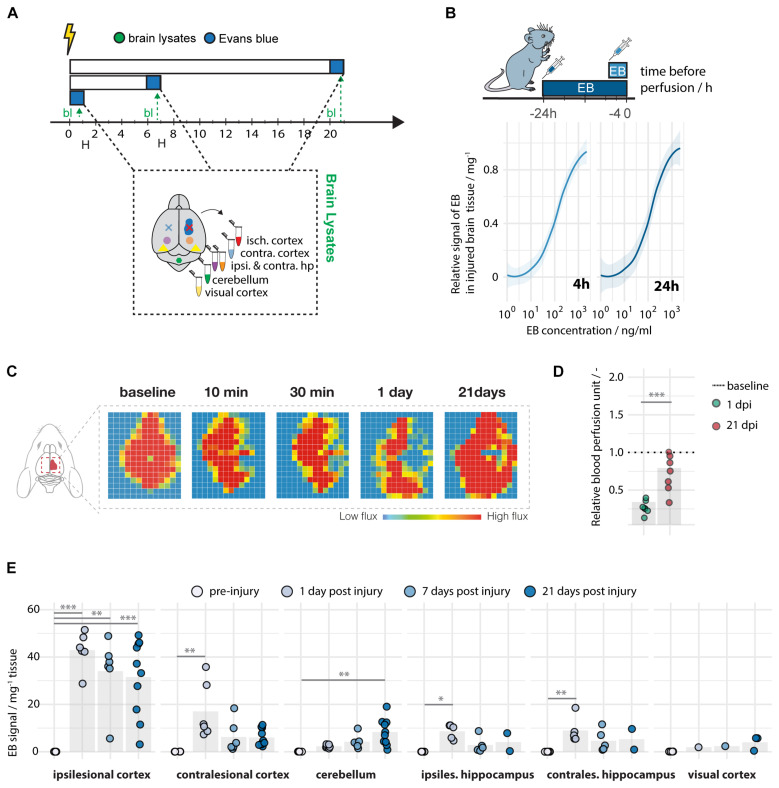
Spatiotemporal leakage following photothrombotic stroke. (A) Schematic representation of time course at baseline (N = 5), day 1 (N = 5–10), day 7 (N = 5–7), and day 21 (N = 2–10) following stroke. (B) Limit of detection and quantification of Evans blue in brain tissue. (C) Representative images of images of cerebral blood perfusion at 10, 30 min, 1 and 21 days following stroke. (D) Quantification of cerebral blood perfusion relative to baseline. (E) Quantitative assessment of Evans blue signal across different brain regions and time points. Data are represented as mean ± SD. Each dot in the plots represents one animal and significance of mean differences between the groups was assessed using Tukey’s HSD. Asterisks indicate significance: ∗P < 0.05, ∗∗P < 0.01, ∗∗∗P < 0.001 isch cx; ischemic cortex, contra cx; contralesional cortex, hp; hippocampus, cb; cerebellum, vcx, visual cortex. EB; Evans Blue, bl; brain lysates.